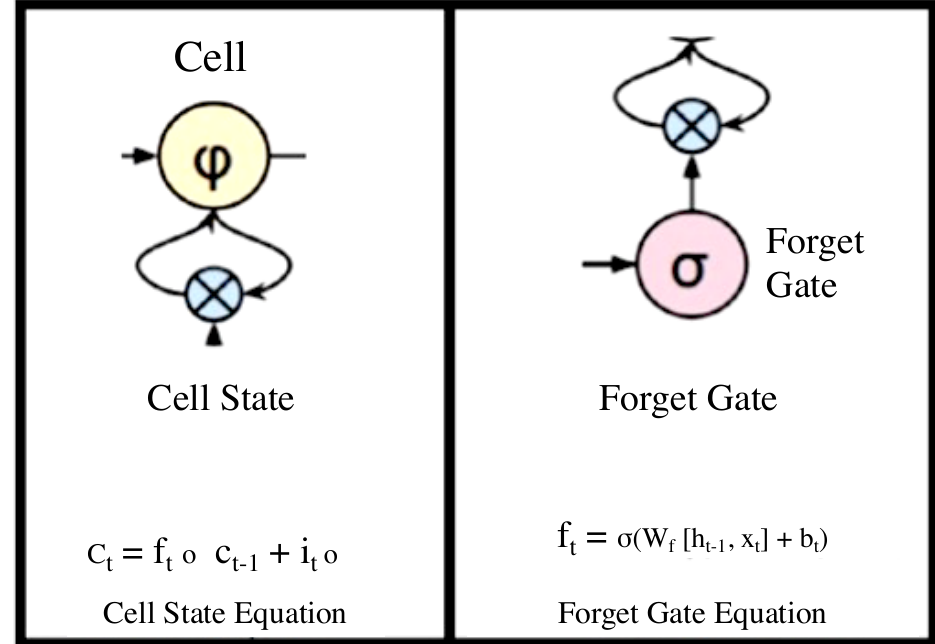
Figure 8. LSTM Cell State and Forget